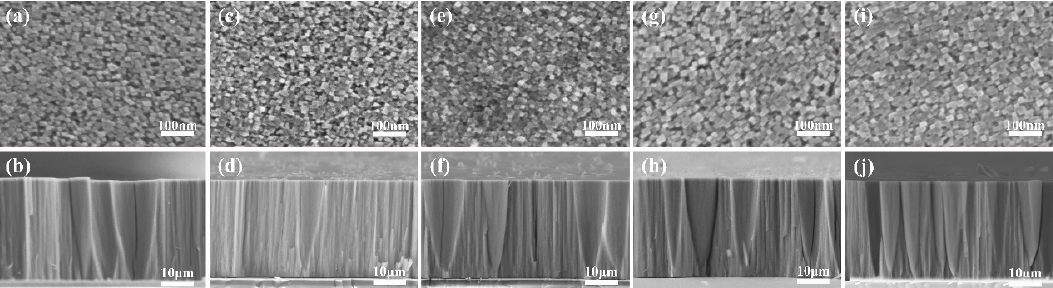
Figure 1. Morphological characterizations of the smooth-surface and rough-surface TiO2 NWAs: ( a , c , e , g , i ) top-surface FESEM image of STO0, STO1, STO2, STO3, STO4, respectively; and ( b , d , f , h , j ) cross-sectional FESEM image of STO0, STO1, STO2, STO3, STO4, respectively.